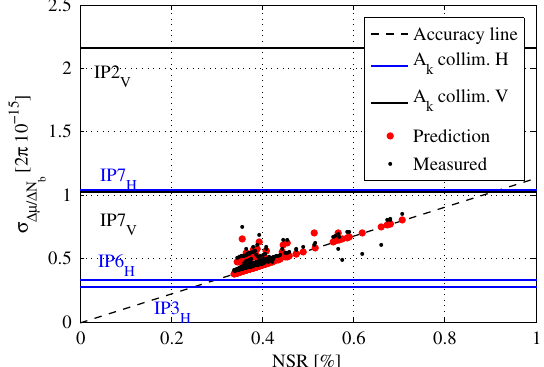
FIG. 8. Phase advance slope uncertainty in the LHC machine. Black dots represent the measured uncertainty for N ¼ 2200 turns and M ¼ 14 measurements over an intensity scan from N 10 11 to N 3 × 10 11 ppb. Red dots represent the pre- b ¼ b ¼ dicted uncertainty with Eq. (31). Horizontal lines are the signal amplitudes expected from the horizontal (in blue) and vertical (in black) collimators. The uncertainty line shows the uncertainty attainable over NSR for average measurement